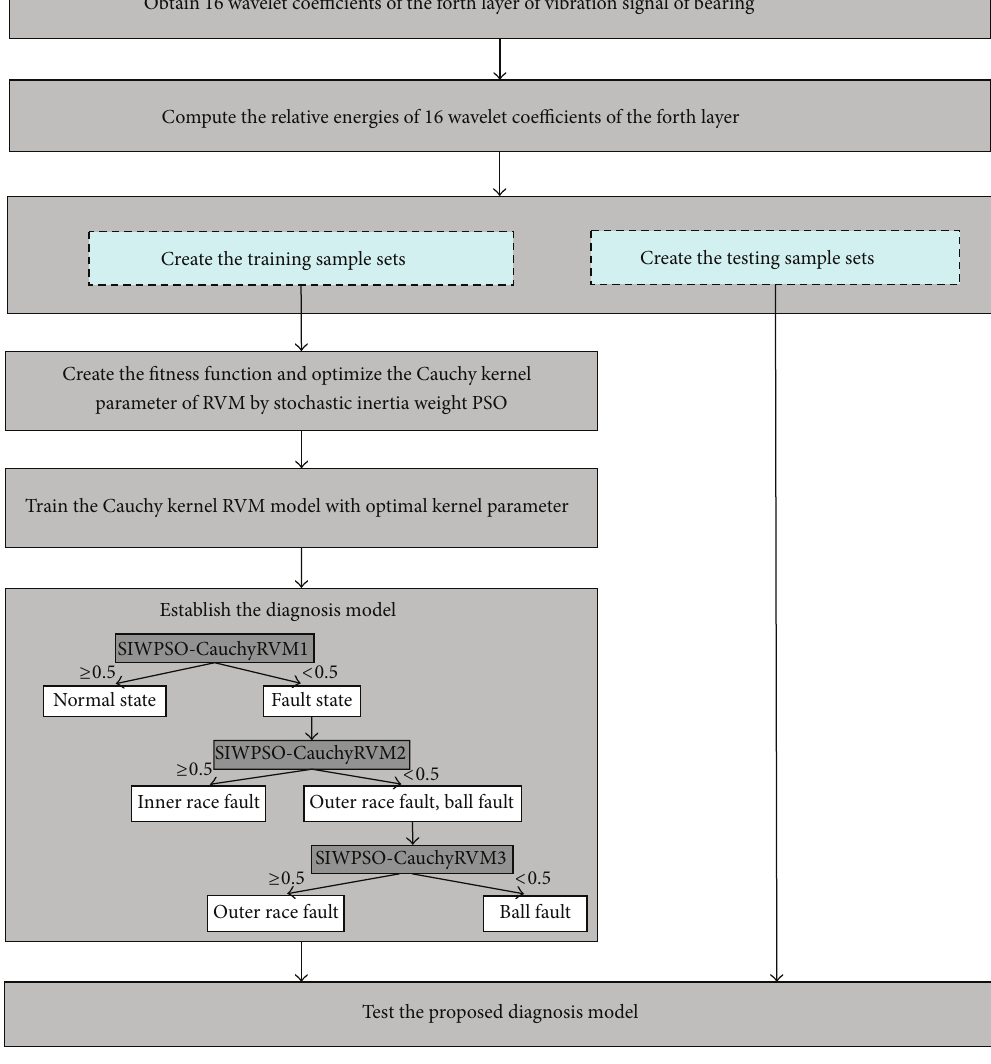
the number of the training samples. The likelihood